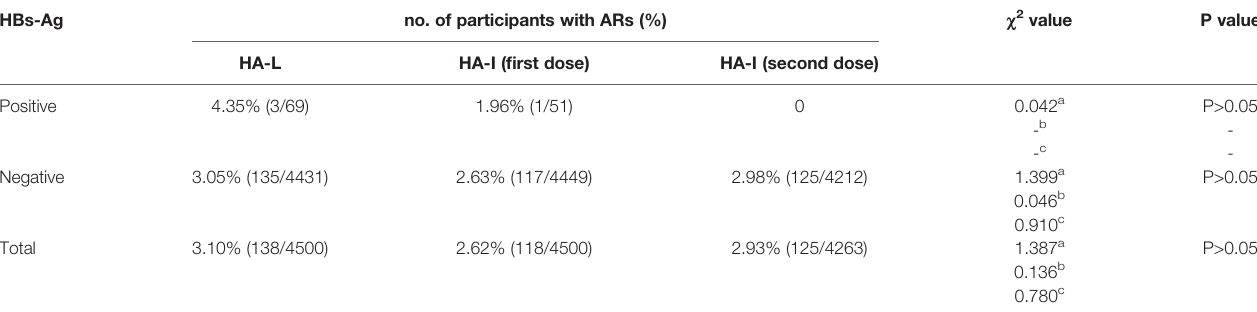
TABLE 2 | The comparison of adverse reactions (ARs) in HBs-Ag-positive or -negative participants between different groups. HBs-Ag